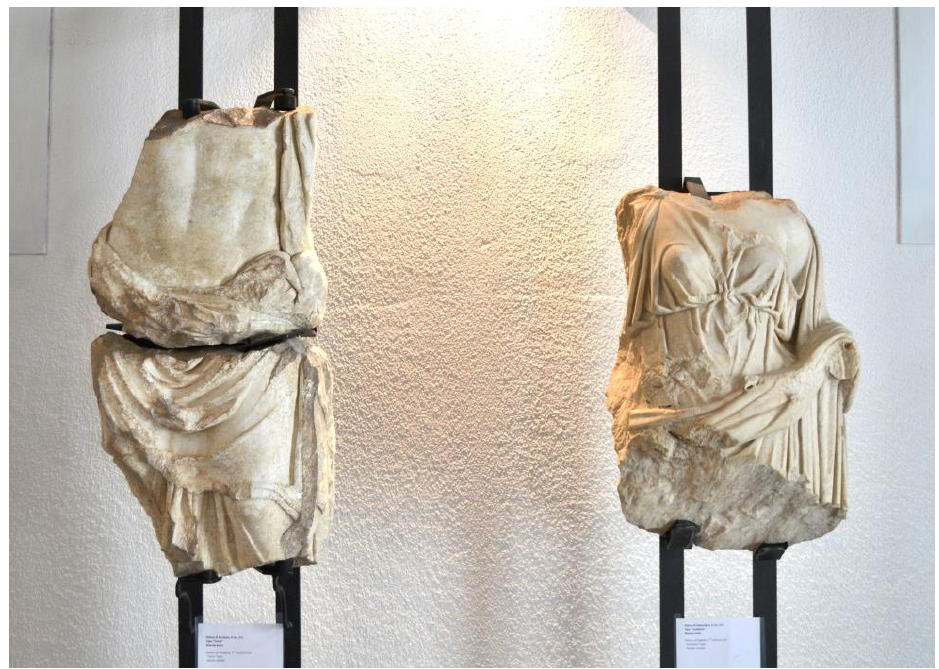
Figure 4. Statues of Aesculapius and Hygeia from the sanctuary of Isis in Lilybaeum.